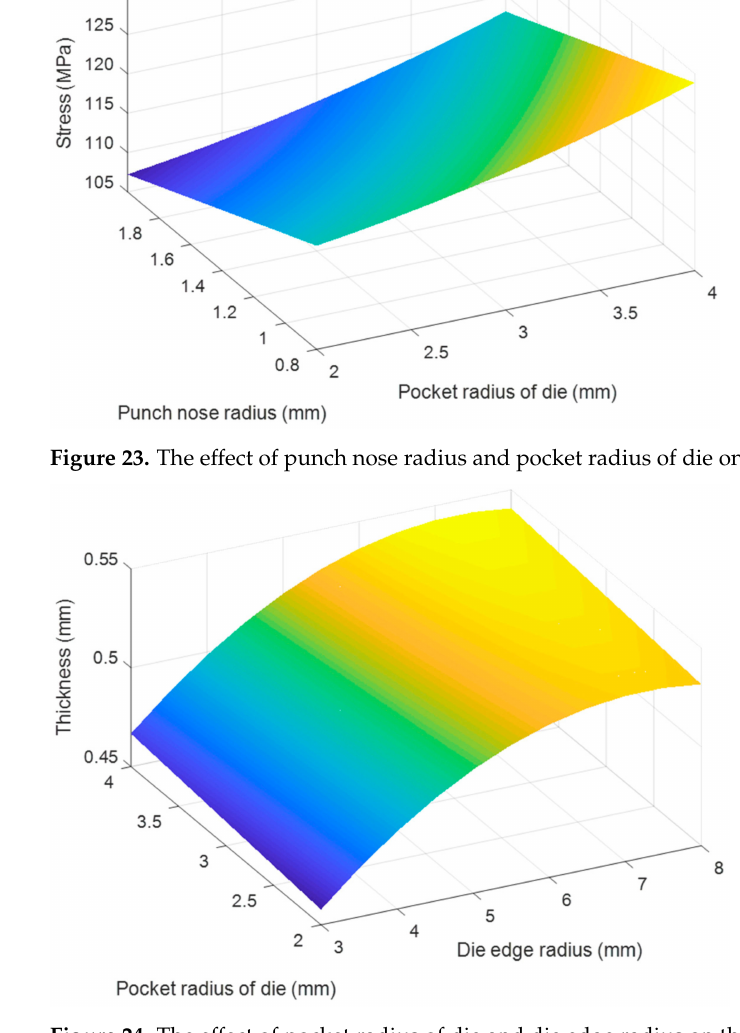
Figure 24. The effect of pocket radius of die and die edge radius on thickness.